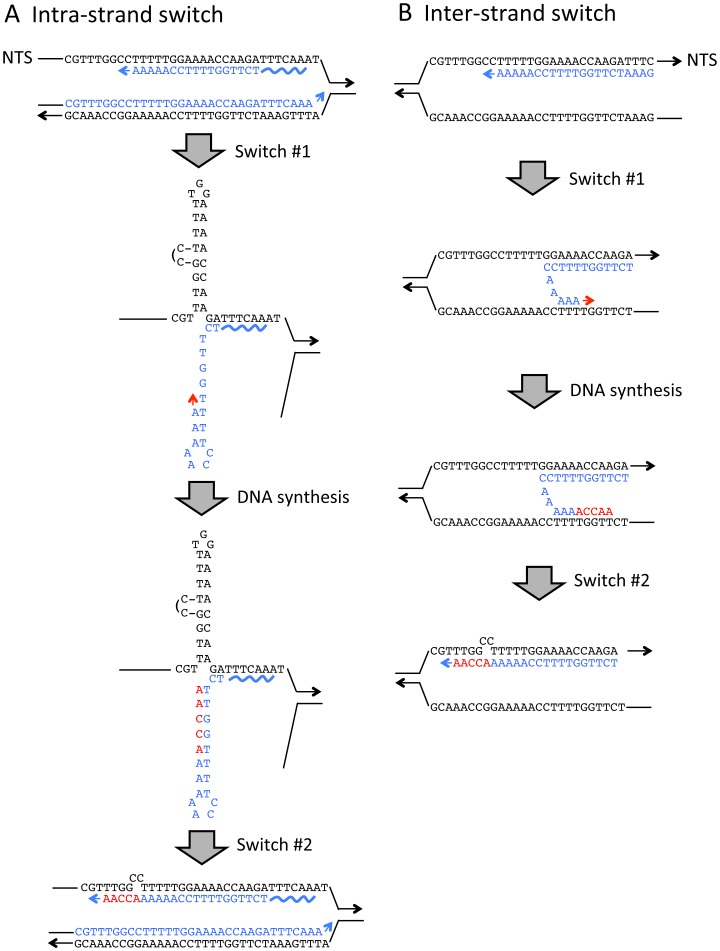
Strand switch models for generating QP mutations.The QP mutation illustrated is the most frequent event observed with the lys2ΔBgl allele (QP #1 in Figure 1A) and can be generated (A) via an intra-strand switch that occurs during lagging-strand synthesis or (B) when the nascent leading strand switches to the lagging-strand template. Arrowheads correspond to 3′ ends of DNA strands and the NTS strand of LYS2 is indicated. Template bases are black; bases incorporated before the first template switch are in blue; and DNA synthesized after the template switch is red. The wavy line corresponds to an RNA primer on the lagging strand.